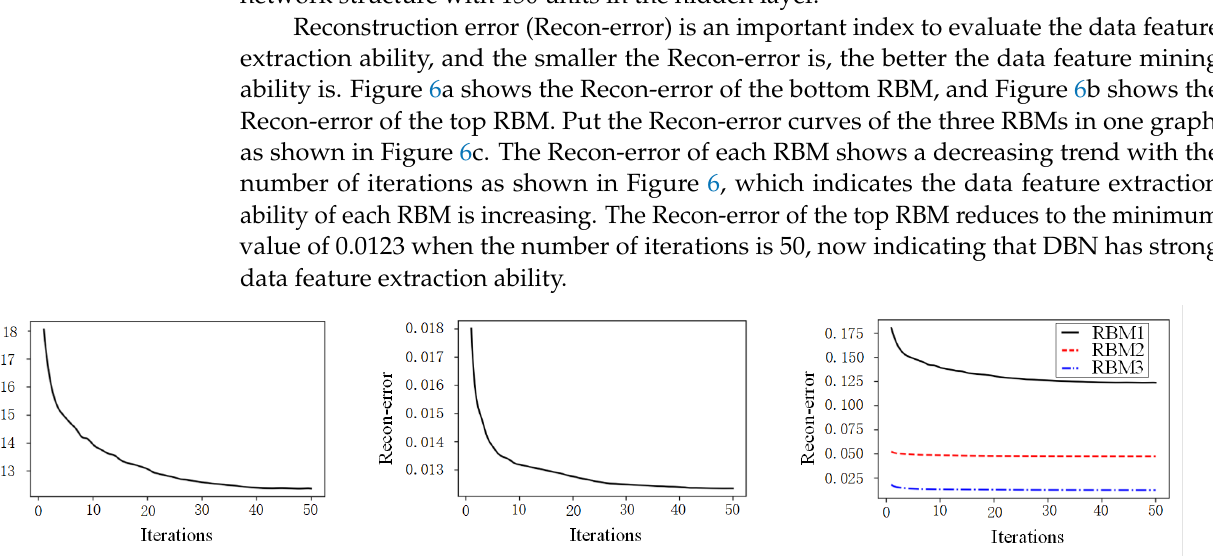
Figure 5. Fault diagnosis accuracy of DBN with the different number of hidden layers and number of units in the hidden layer. ( a ) Accuracy of DBN with different hidden layers. ( b ) Accuracy of DBN with different hidden units.